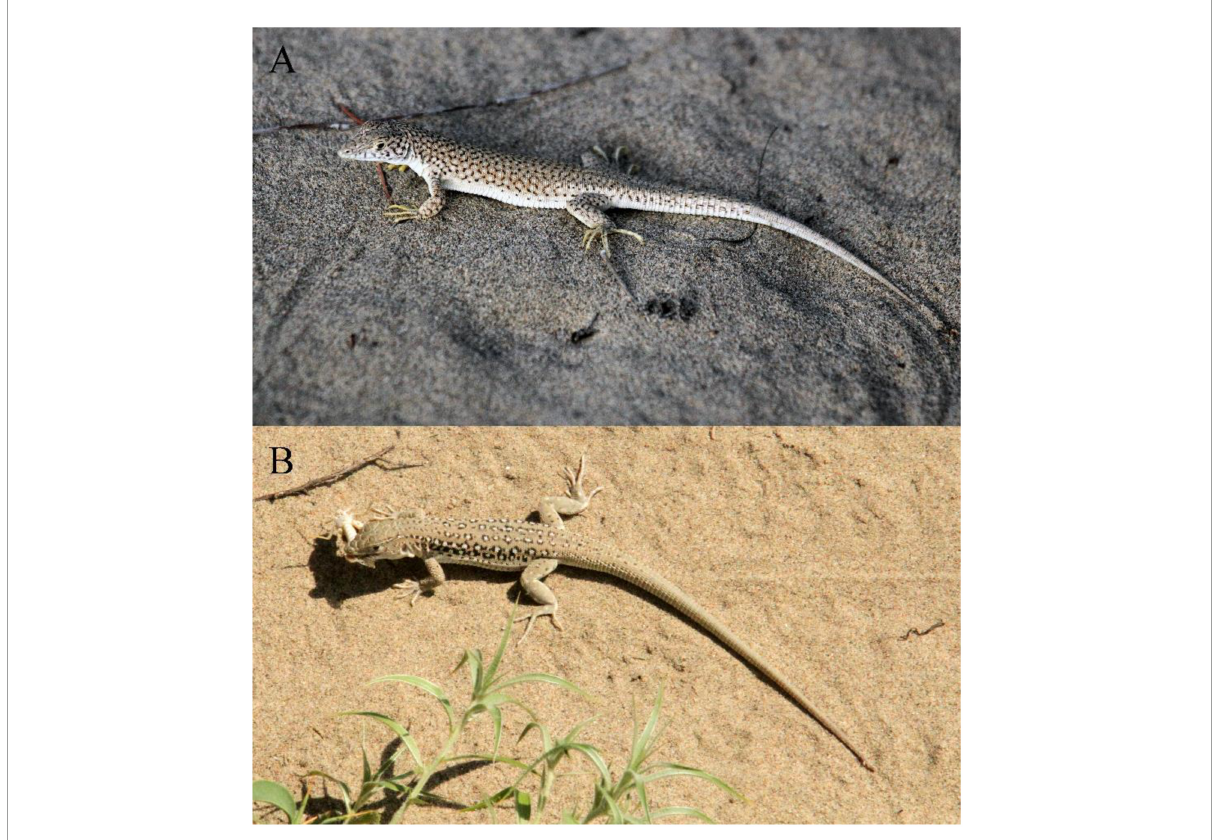
FIGURE1 Ecological photos of Eremias grammica (A) and Eremias velox (B) . (Photos by Lei